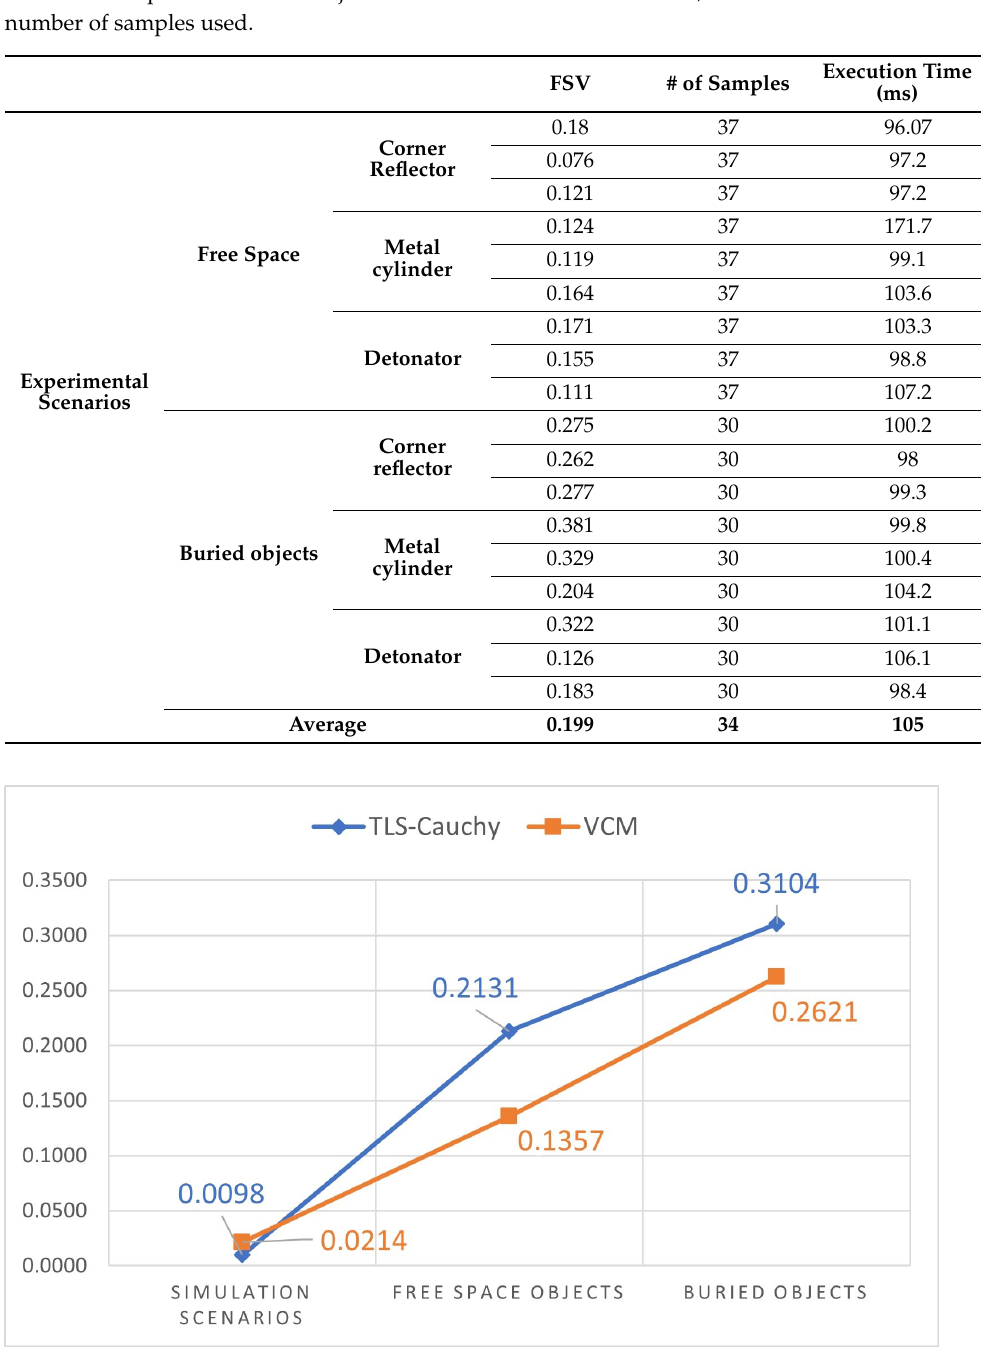
Figure 13. FSV results for both the Cauchy and VCM methods, according to the comparison of the input signals and the corresponding reconstruction in the simulated and experimental